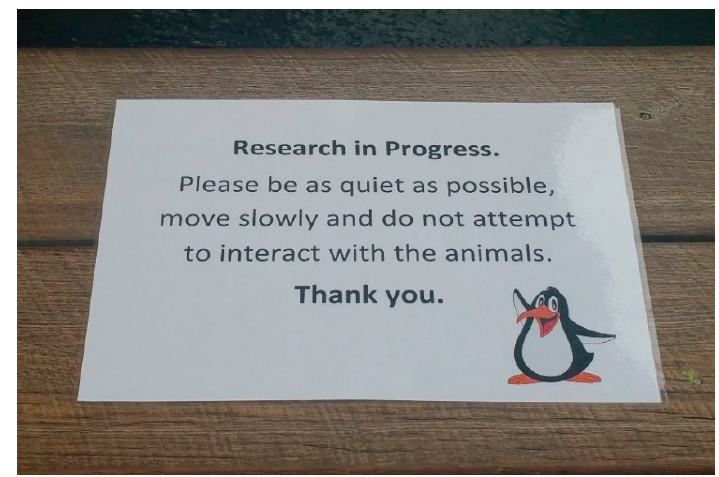
Figure 3. Signs used to attempt to regulate visitor behaviour.